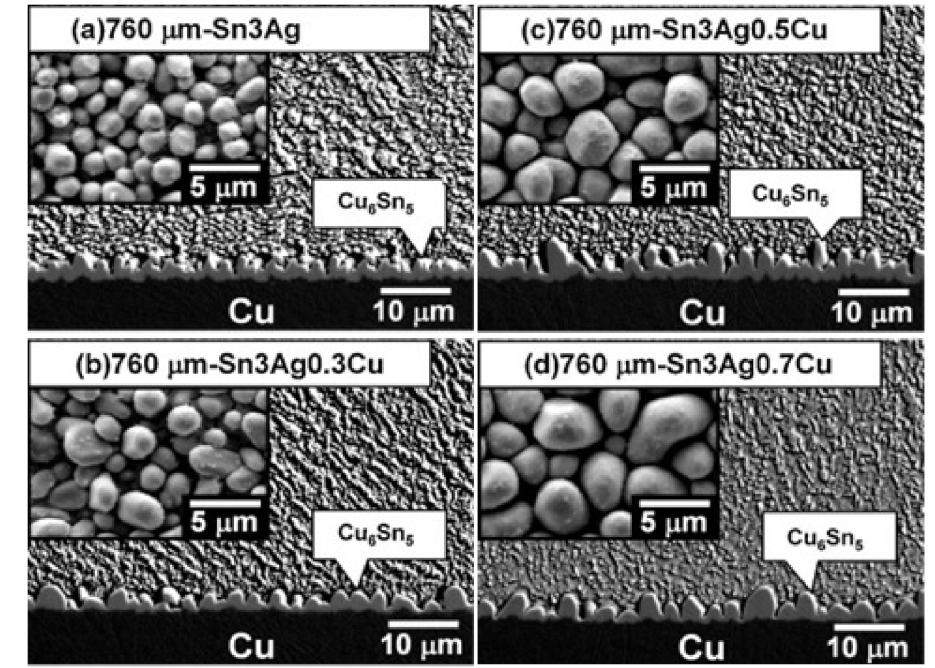
Figure 5. Cross-section and top-view (insets) micrographs showing the microstructure for the Sn3Ag0.5Cu solder with different ball sizes.( a ) 960, ( b ) 760, ( c ) 500, and ( d ) 400 µ m